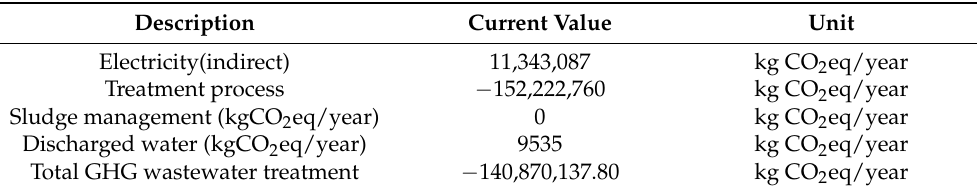
Table 5. Detailed greenhouse gas assessment data of ECAM in wastewater treatment stage—WWTP A of